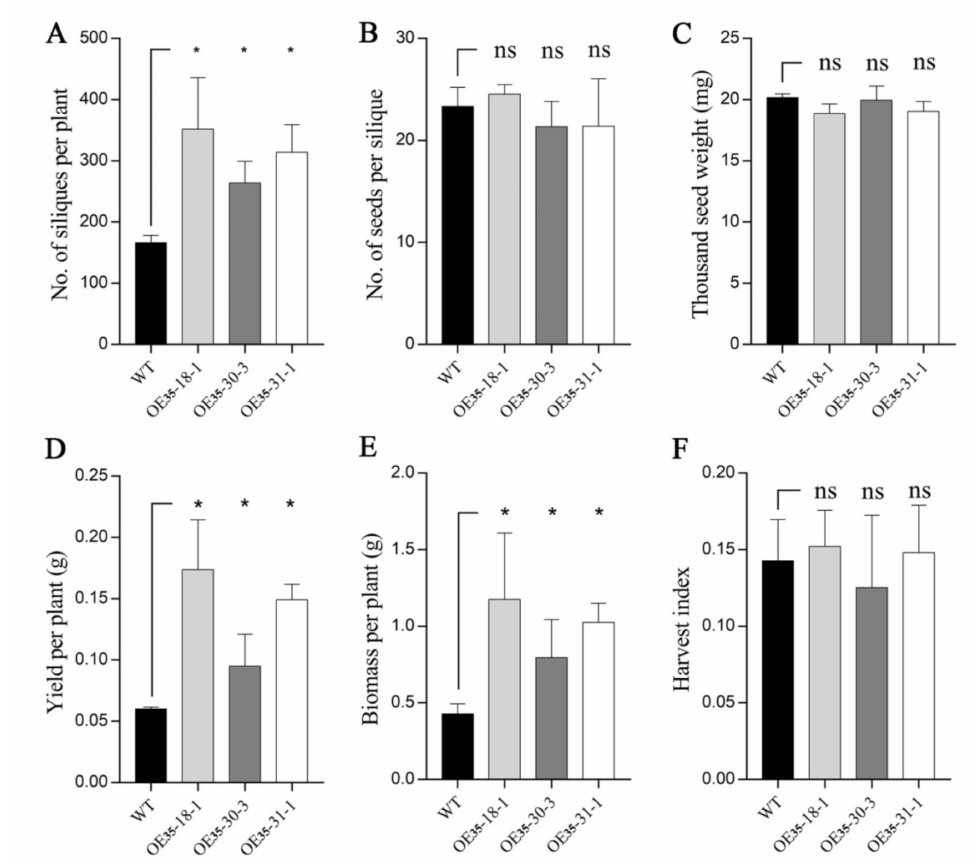
Figure 6. Yield-related traits of BnERF114.A1 transgenic plants. ( A ) number of siliques per plant. ( B ) number of seeds per silique. ( C ) thousand-seed weight (mg). ( D ) yield per plant (g). ( E ) biomass per plant (g). ( F ) harvest index. Values represent the data of 3 wild-type and 10 OE 35 transgenic plants. Asterisk indicates significant differences at the p = 0.05 level. “ns” indicates non-significant differences at the p = 0.05